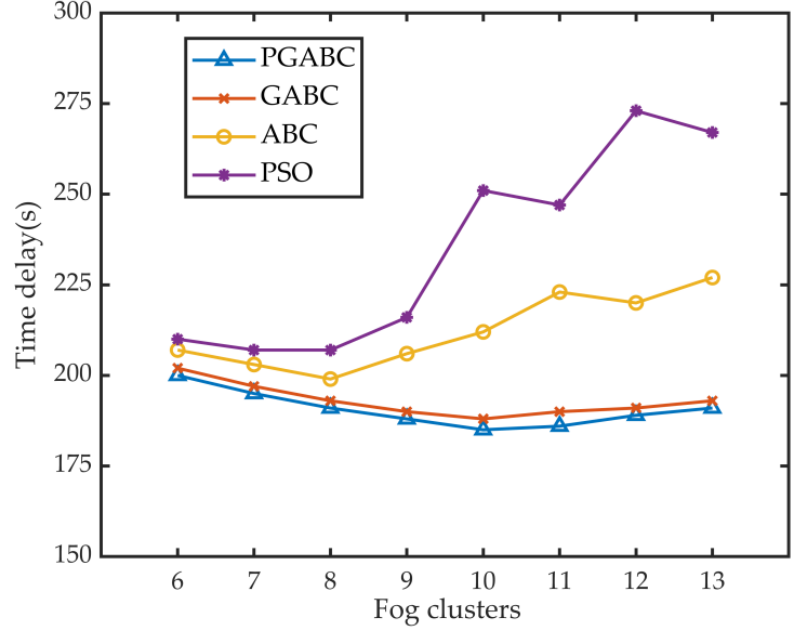
Figure 13. Total delay for the four algorithms varying with fog cluster number.